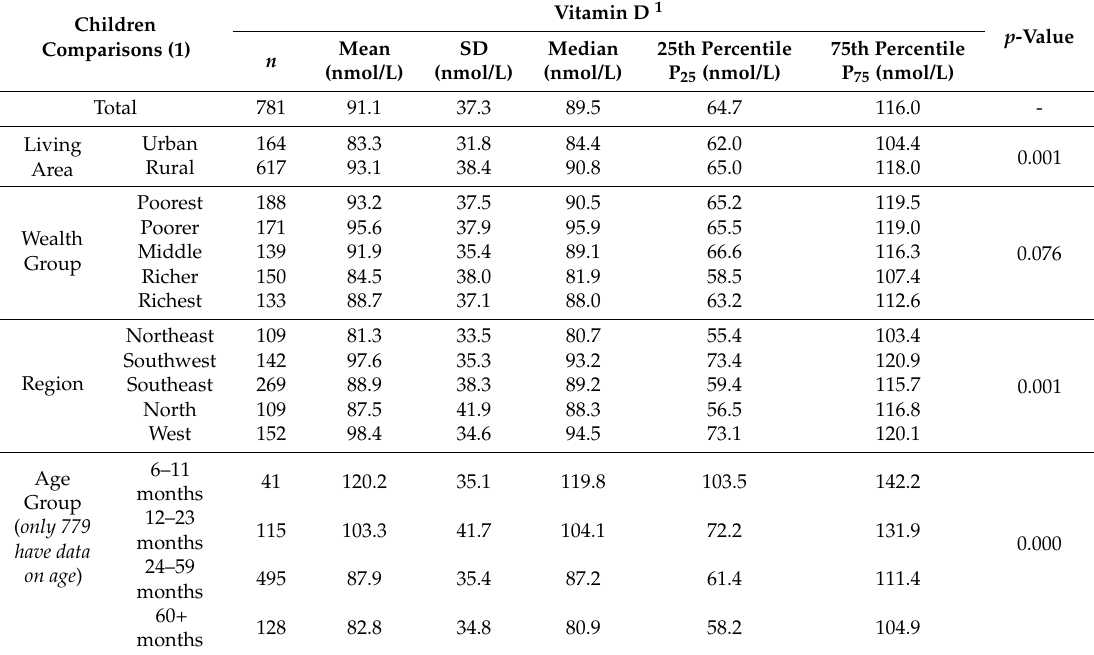
Table 3. Comparison of relationships between vitamin D concentration status and living area, wealth group, and age groups of the children.